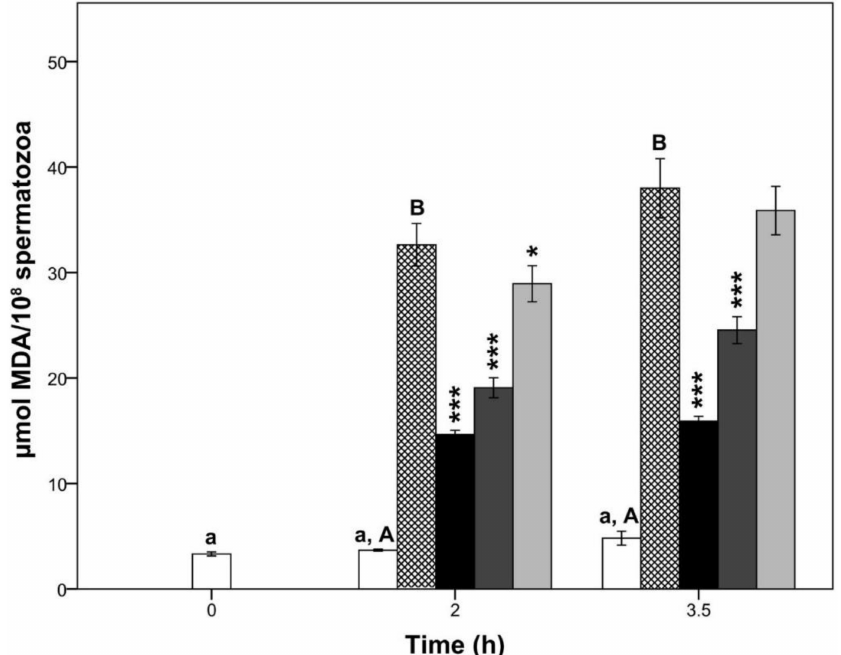
Figure 2. Lipid peroxidation in boar sperm samples submitted to oxidative stress (CTR except) and supplemented with aminoguanidine. Different superscript lower-case letters indicate significant differences ( p < 0.05) among times for the control group without induced oxidative stress. Different superscript upper-case letters in the same column indicate significant differences ( p < 0.05) between the control group with and without induced oxidative stress within each given time. The asterisks indicate significant differences between the treatment and the control submitted to induced oxidative stress within each given time (* p < 0.05; *** p ≤ 0.001). MDA = malondialdehyde; white bars = control samples; crossed bars = control samples under induced oxidative stress; black bars = 10 mM aminoguanidine; dark grey bars = 1 mM aminoguanidine; and light grey bars = 0.1 mM aminoguanidine. Data are shown as mean ± standard error of 5